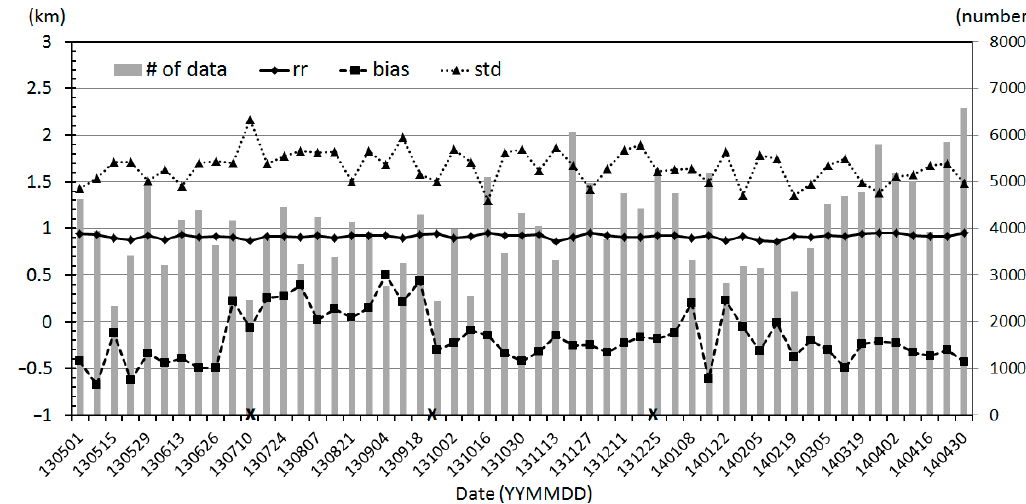
Figure 5. Time series of the daily validation scores of standard deviation (STD; dotted line), correlation coefficient (solid line), and bias (dashed line) from May 2013 to April 2014. The number of validation data (grey bar) from the cloud-top height (CTH) comparison between the Spinning Enhanced Visible and Infrared Imager (SEVIRI) and Cloud Profiling Radar (CPR) products is also shown. Black x marks on the x-axis indicate the dates the bias correction was updated.